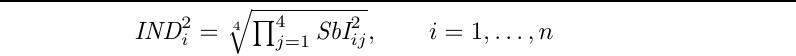
Table 2: The Social Indicator of region